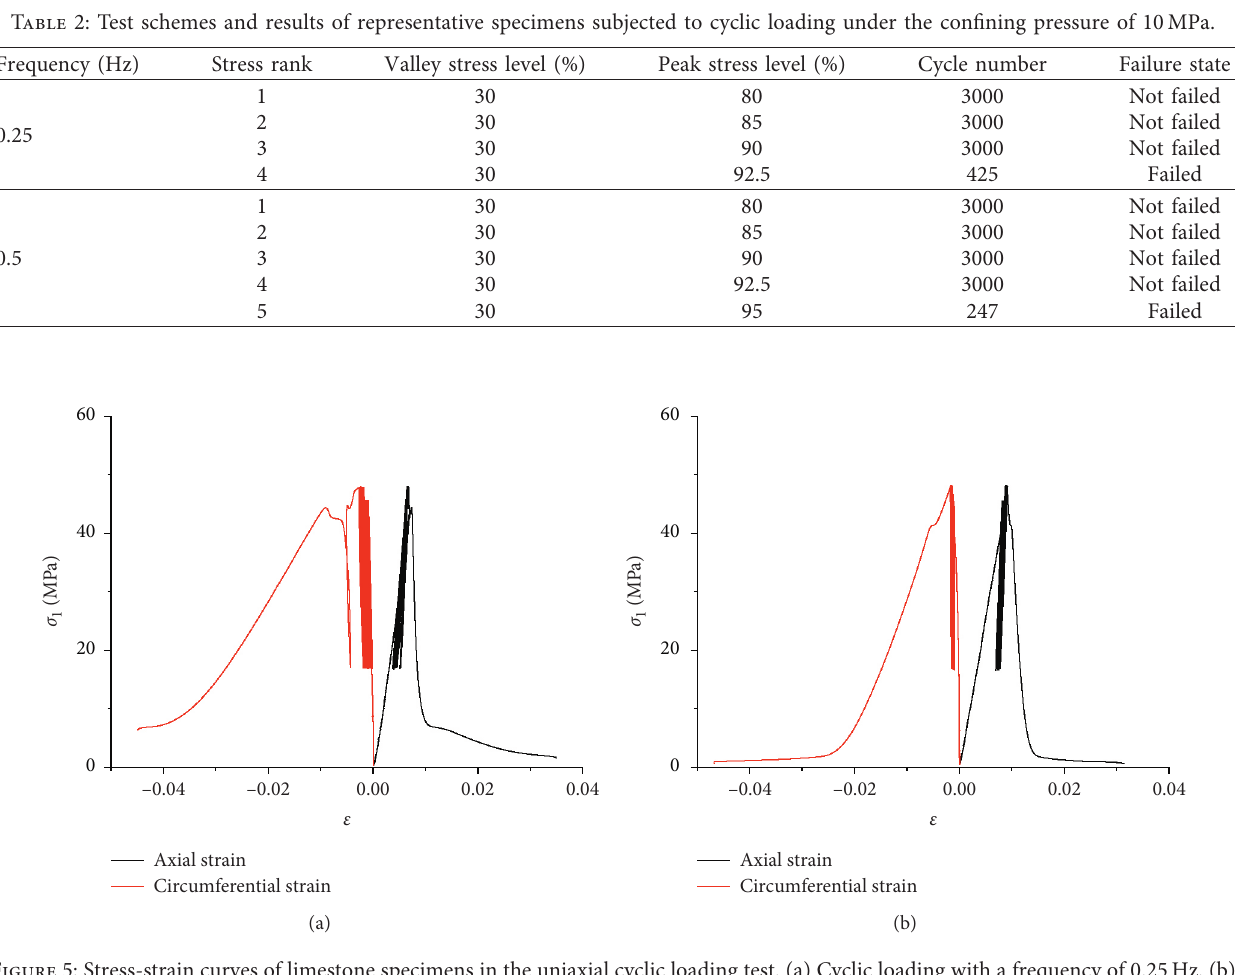
Figure 5: Stress-strain curves of limestone specimens in the uniaxial cyclic loading test. (a) Cyclic loading with a frequency of 0.25Hz. (b) Cyclic loading with a frequency of